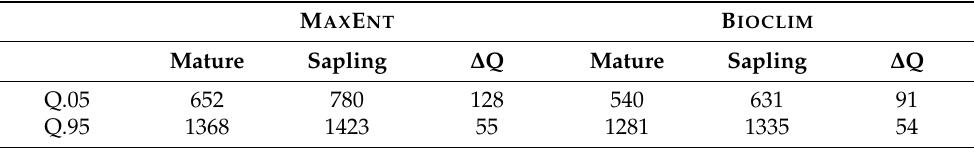
Figure 4. Altitudinal distributions of the “sapling” and “mature” life stages. The density curves show the distributions of both groups throughout the altitudinal gradient, which were obtained using the potential habitats projected by the models (M AX E NT and B IOCLIM ). The 0.95 and 0.05 quantiles were identified as the upper and lower limits, respectively. The altitudinal displacement of the upper and lower limits was calculated based on the difference between the quantiles ( Δ Q) of the two life stages. Table 2. Altitudinal limits of the projections (M AX E NT and B IOCLIM ) for Abies pinsapo Boiss. in the Baetic System.